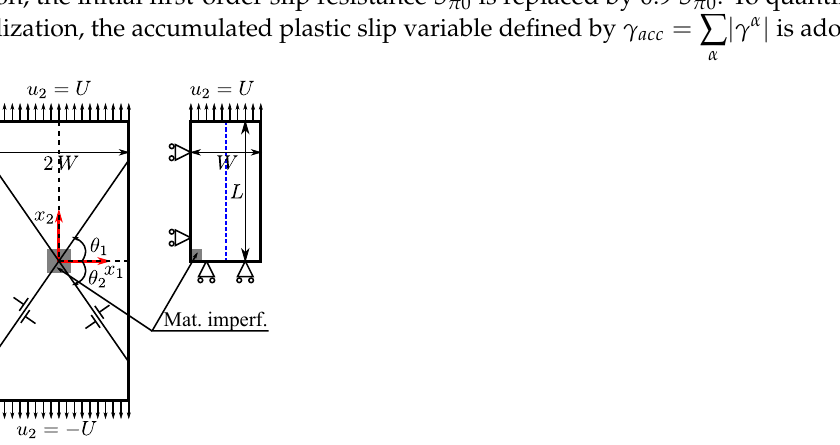
Figure 8. Uniaxial tension of a single crystal plate with two slip systems symmetrically oriented with respect to the tension direction. Table 3. The material parameters implied for uniaxial tension of a single crystal plate, inspired by